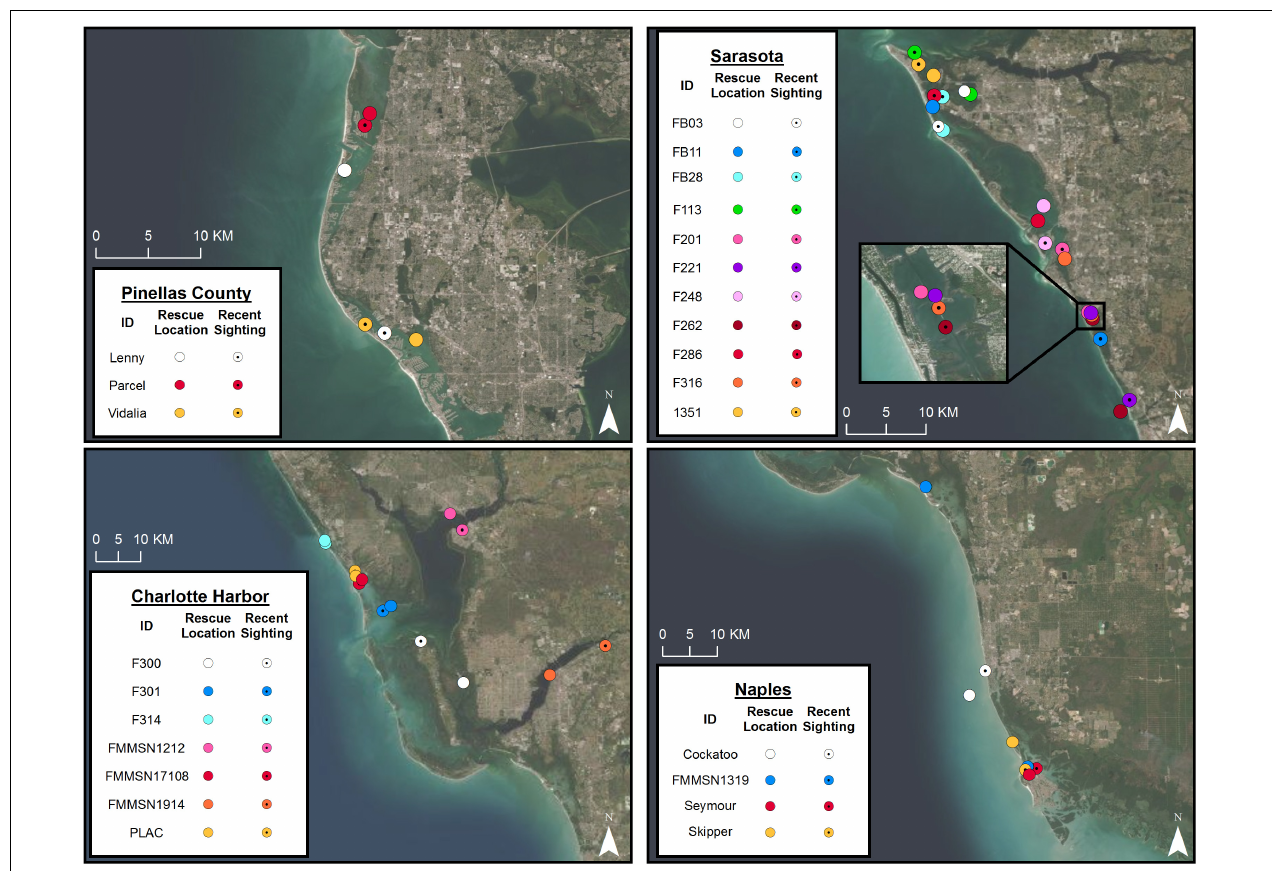
FIGURE 2 | Map of rescue locations versus most recent sighting location for intervention cases observed post-rescue. Nearly all individuals remained within the dolphin community from which they were